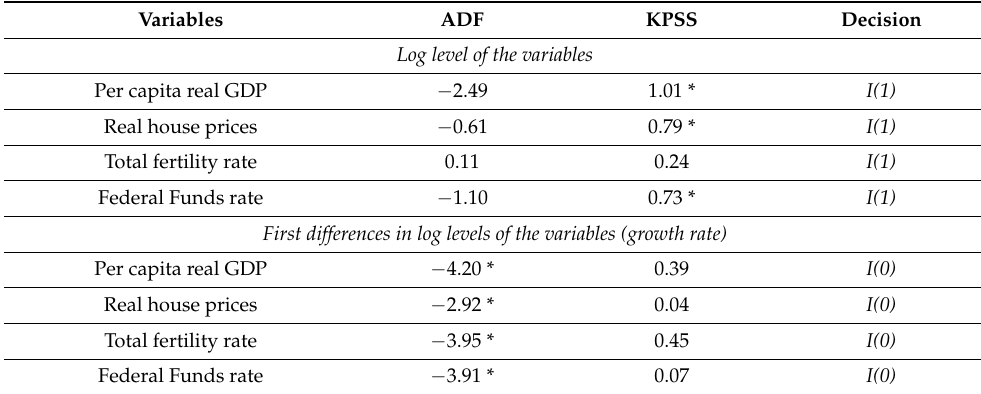
Table A1. Unit root and stationarity